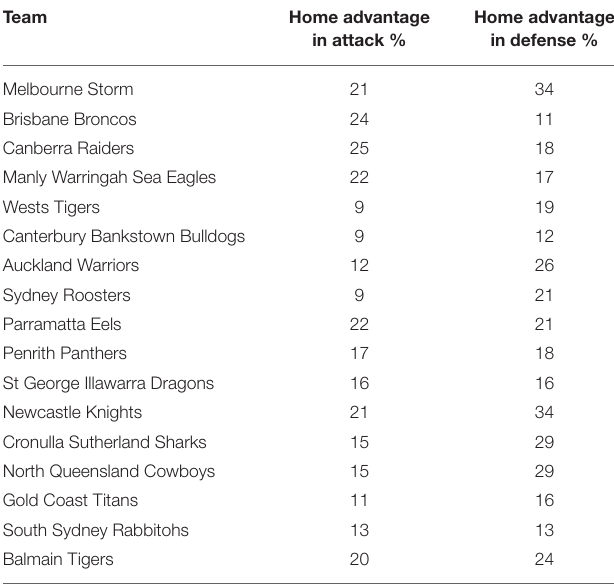
TABLE 1 | Average value of home advantage in attack and defense in the